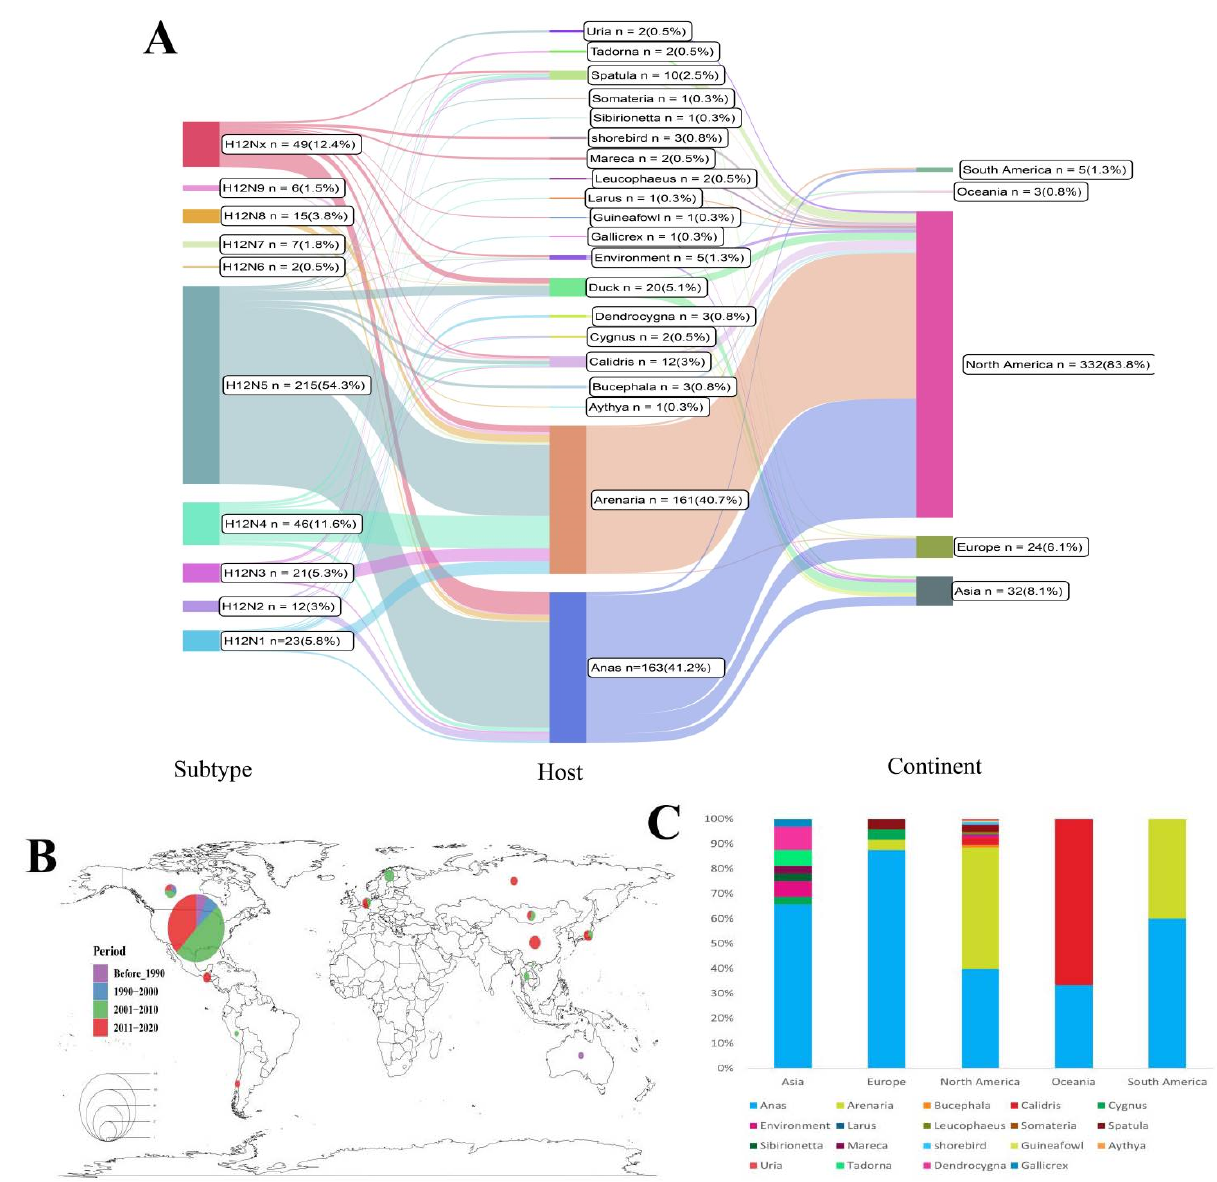
Figure 1. The detailed information of H12 IAVs. ( A ) The map of the subtypes, hosts (including genus/type of birds or environment), and continents of all H12 IAVs. ( B ) The spatial and temporal distribution of H12 IAVs. The pie chart shows the composition of the different periods, and the circle size represents the number of H12 strains. ( C ) The host species of H12 IAVs detected in 5 major regions around the world.